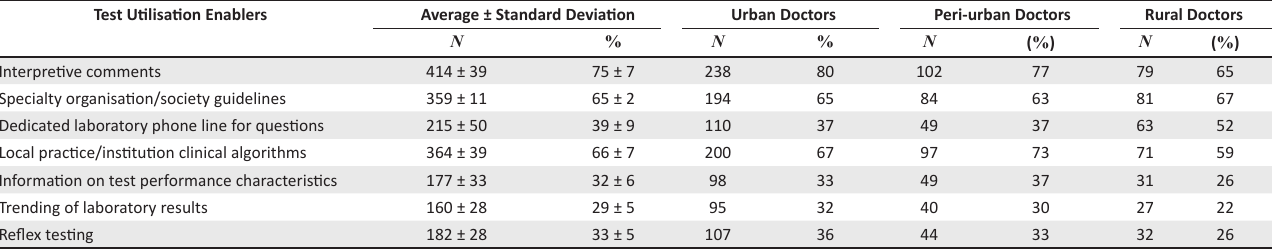
TABLE 2: Availability of test utilisation enablers for the urban, peri-urban and rural doctor cohorts, † South Africa, 13 October 2015–13 November 2015. Test Utilisation